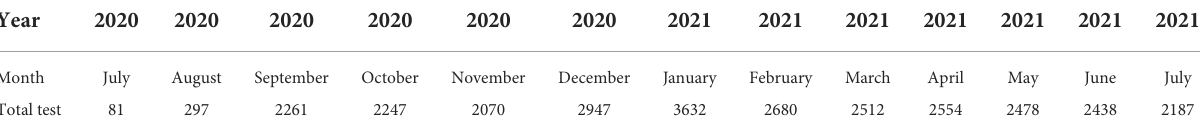
TABLE 3 Monthly distribution of SARS-CoV-2 PCR test for prospective travelers at the NWC from July 2020 to July